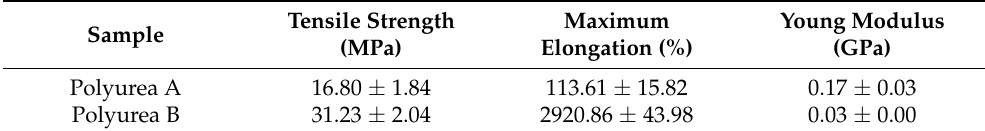
Table 5. Tensile test results.